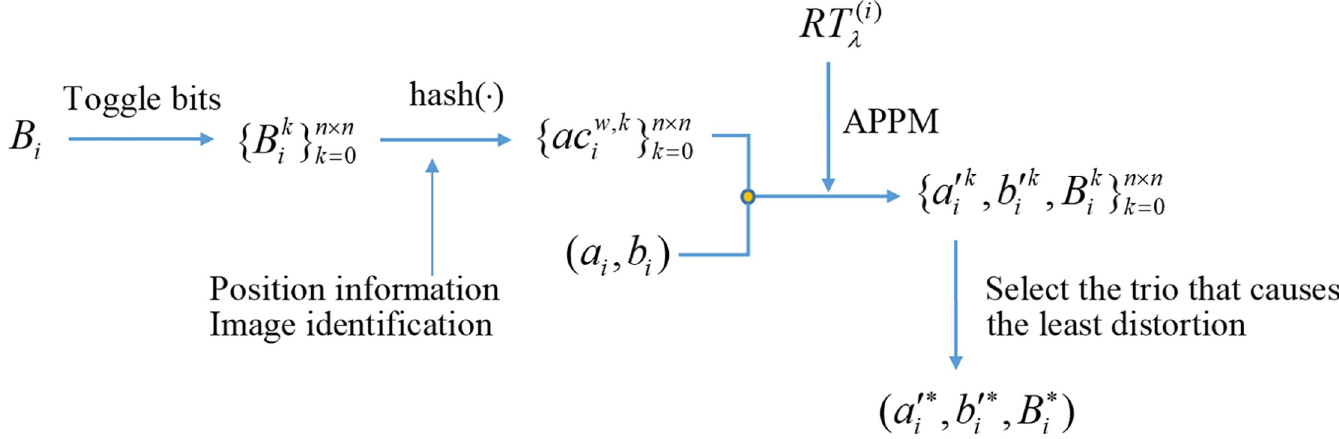
Fig 4. Schematic diagram of the bit toggling